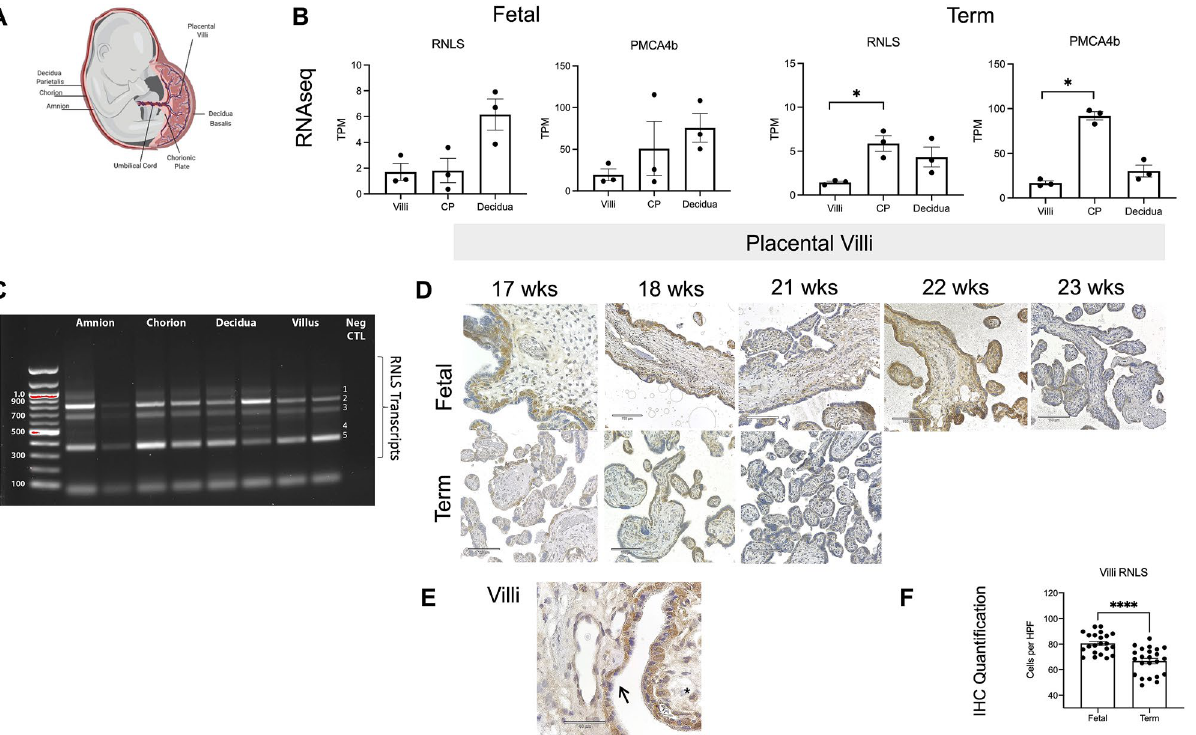
Figure 1. RNLS is present in placental villi throughout gestation. (A) Cartoon image of a fetus with labeled parts of the placenta. Made with BioRender. (B) Expression of RNLS and its receptor, PMCA4b, in villi, chorionic plate (CP), and decidua in fetal and term tissue (n = 3 for both). TPM- transcripts per million reads. *p-value = 0.0250 (Term RNLS); p-value = 0.0107 (Term PMCA4b) upon post hoc analysis after nonparametric Kruskal Wallis (K-W) test. Alpha level = 0.05. (C) PCR analysis of term placental layers performed in duplicate n = 1. (D) RNLS labeling in placental villi throughout development during fetal and term-time points. (E) Representative placental villi labeling with black arrow pointing to a region of RNLS localization along the border of placental villi and * indicating cells staining for RNLS within the villi interstitium. Immunohistochemistry with hematoxylin staining for RNLS using m28-RNLS antibody at 20x (D) and 60x (E) . (E) Quantification of RNLS positive cells in placental villi during fetal and term-time points (n = 6). HPF-high-power field. *p-value < 0.0001 upon post hoc analysis after two-tailed Mann–Whitney test. All graphs use the mean for average values and standard error for error bars. Black arrow pointing at RNLS positive